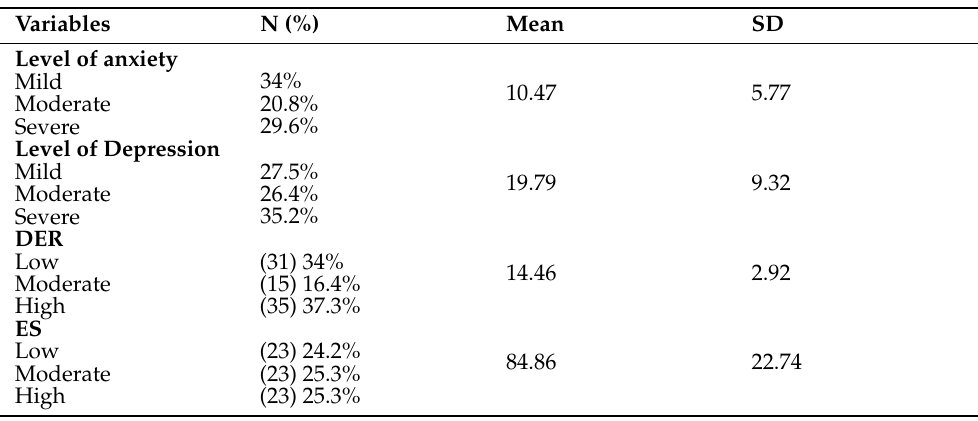
Table 2. Level of anxiety, depression, DER, and